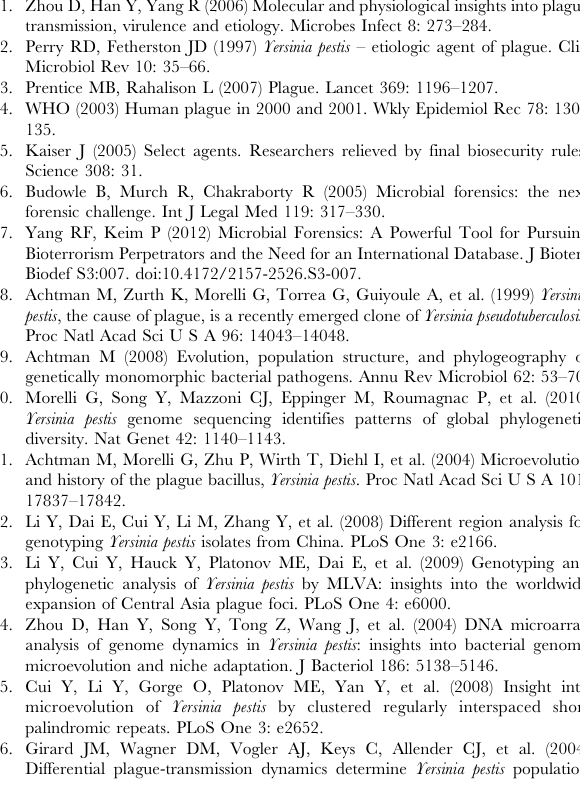
Table S1 Y. pestis strains sequenced in previously research. Table S2 Data production of the strains sequenced in